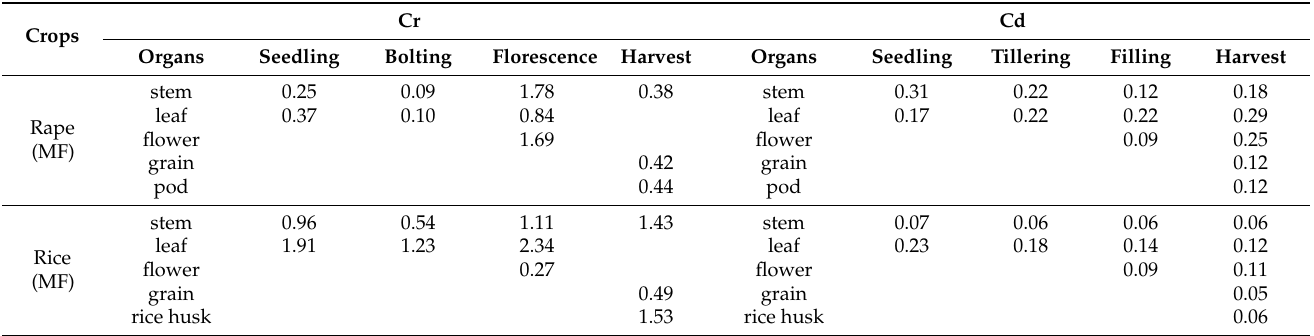
Figure 3. Speciation variation of soil Cd under rape-rice rotation mode. (Notes: ( a ) is 0–20cm, ( b ) is 20–40 cm, EXC is the exchangeable fraction, CAR is carbonate fraction, OX is iron-manganese oxide bound fraction, OM is organic-bound fraction, RES is residual fraction). Table 3. Transport coefficients of heavy metals in their organs under the rape-rice rotation